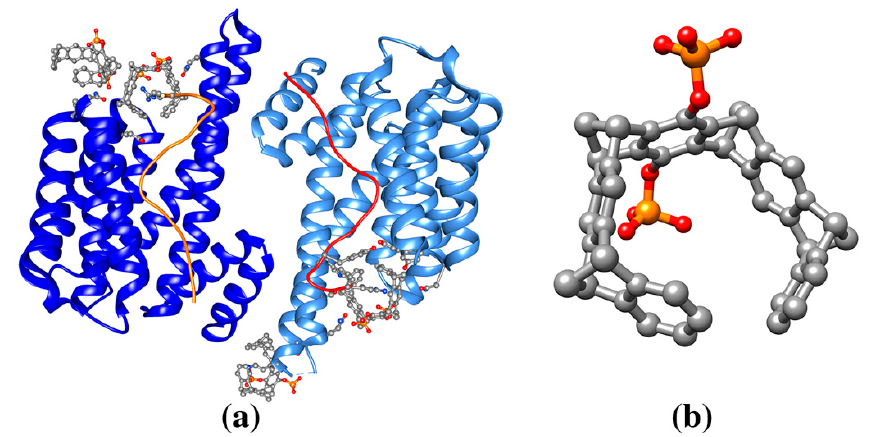
Figure 9. ( a ) Ribbon drawing of binding protein 14-3-3 protein zeta/delta in complex with phosphatase peptide (orange string) and molecular tweezer CLR01 (pdb entry 5m37). The cavity of CLR01 molecules host a side chain of an arginine or a lysine residue. ( b ) CLR01 molecule (cif code 9SZ).